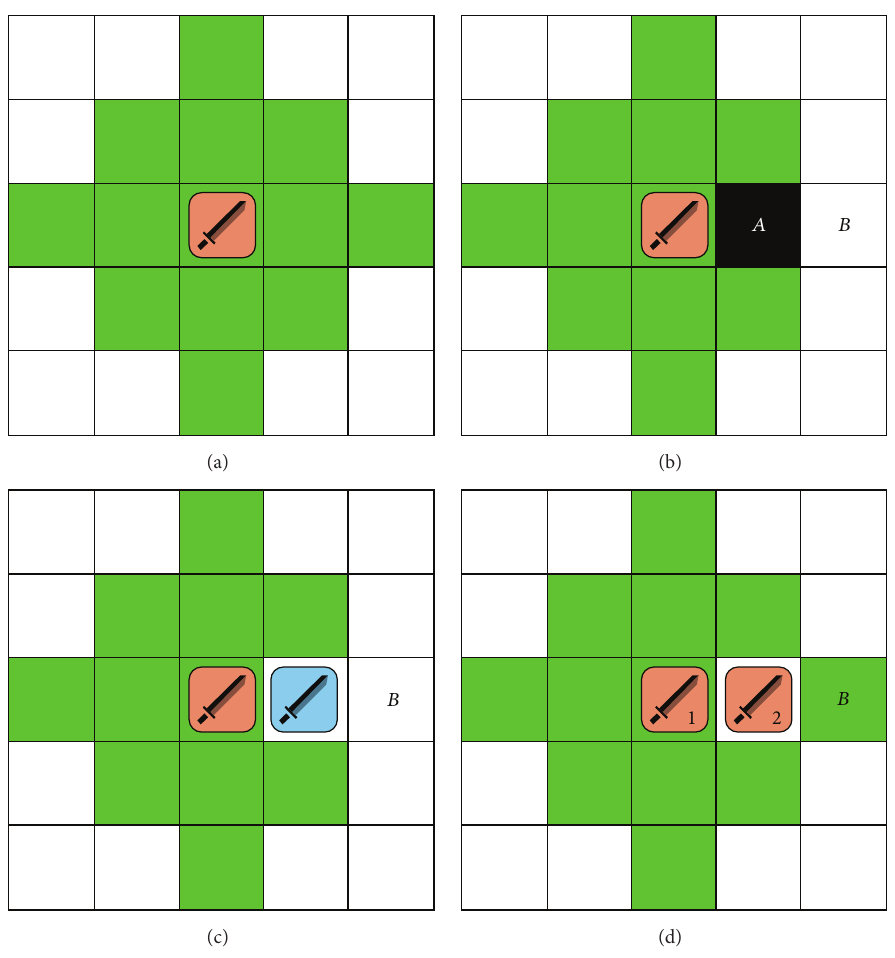
Figure 4: Green tilts illustrate the movement range of a swordsman, whose movement point is 2. The movement cost of each tilt is 1. (a) No obstacle. (b) Tilt 𝐴 is an obstacle and thus tilt 𝐵 is out of the movement range. (c) The swordsman cannot pass the enemy to reach tilt 𝐵 . (d) The swordsman can pass units of the same side to reach tilt 𝐵